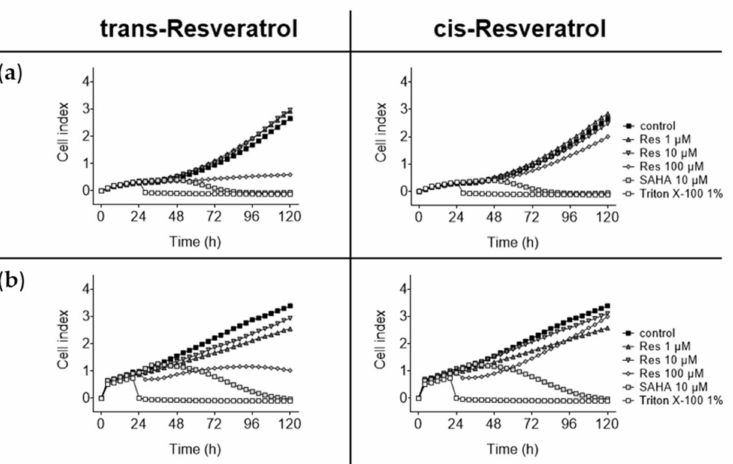
Figure 4. Real time proliferation assay. ( a ) HepG2 and ( b ) Hep3B cells were exposed to different concentrations of trans- and cis-resveratrol (1 µ M, 10 µ M, 100 µ M) or solvent as control and monitored for 96 h by measuring cellular impedance at 30 min intervals. In the graph, 4 h intervals are shown. The xCELLigence ® SP system was used for this purpose. Exposure to 10 µ M SAHA was used as positive control and exposure to 1% ( v / v ) Triton X-100 resulted in complete cell death. Data were calculated using RTCA Software Pro 2.3.2 (Agilent Technologies Inc., Santa Clara, CA, USA). For each cell line, the mean values of one representative run out of three, measured as quadruplicates, are shown. Res, resveratrol; SAHA, suberoylanilide hydroxamic